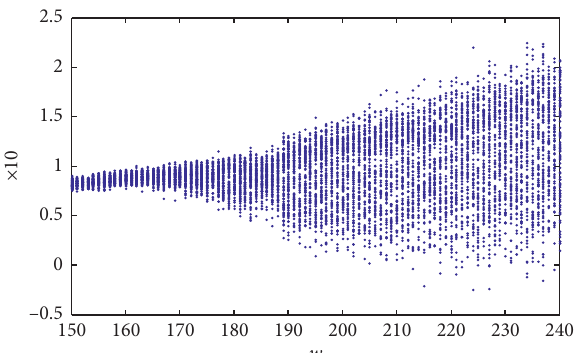
without perturbation, ω � 175. 10